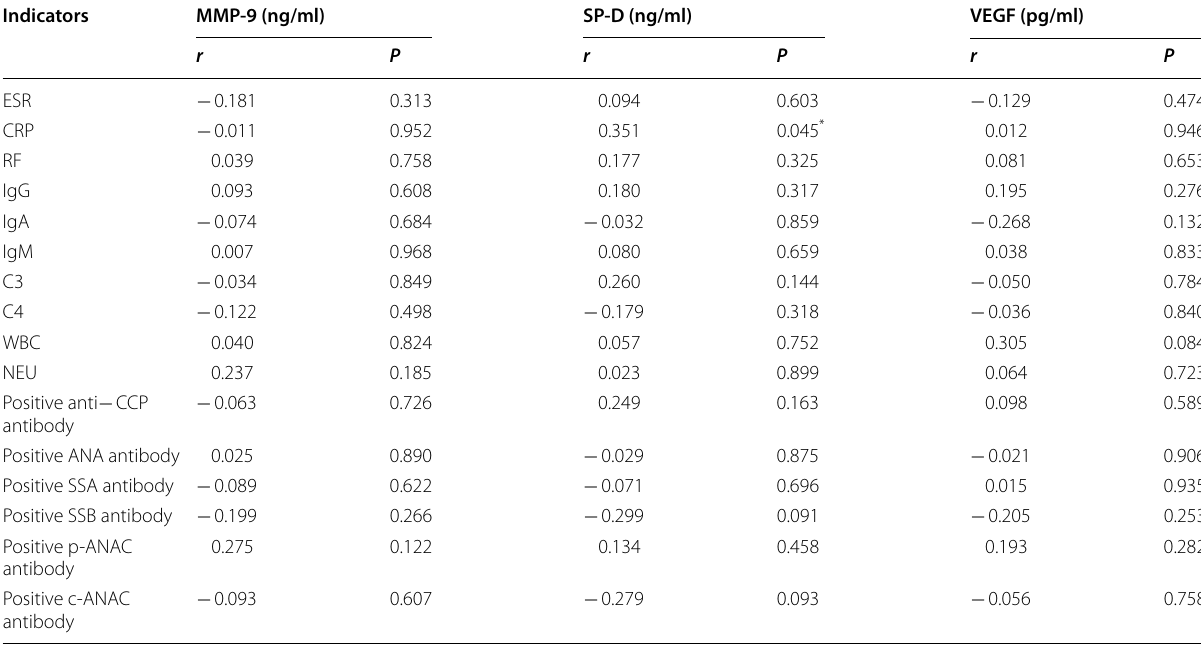
* mean P < 0.05 (correlation was considered significant) ESR erythrocyte sedimentation rate, CRP c-reactive protein, RF rheumatoid factors, IgG immunoglobulin G, C3 complement C3, WBC whitebloodcell, NEU neutrophilic granulocyte, CCP cyclic cirullinated peptide, ANA antinuclear antibody, SSA anti-Sjogren syndrome A antibody, ANCA anti-neutrophil cytoplasmic antibody